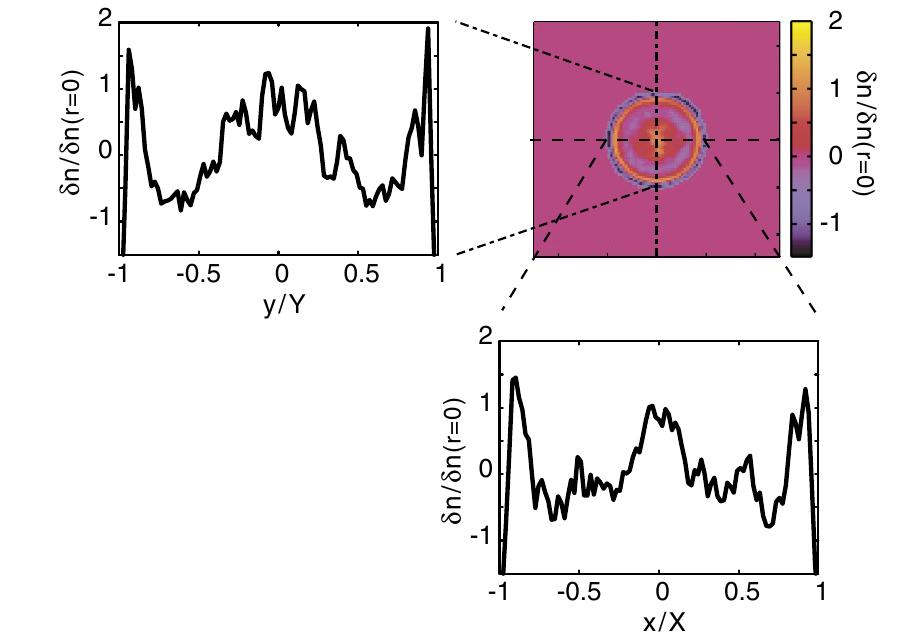
FIG. 9. (Color) Normalized perturbed density given by particle simulation in the case of the initial KV beam at 86 (cid:7) 1 = 4 lattice period. Contour map shows normalized perturbed density in transverse ( 10 cm (cid:9) 10 cm ) real space. Envelope radii are X (cid:2) Y (cid:2) 1 : 9136 cm